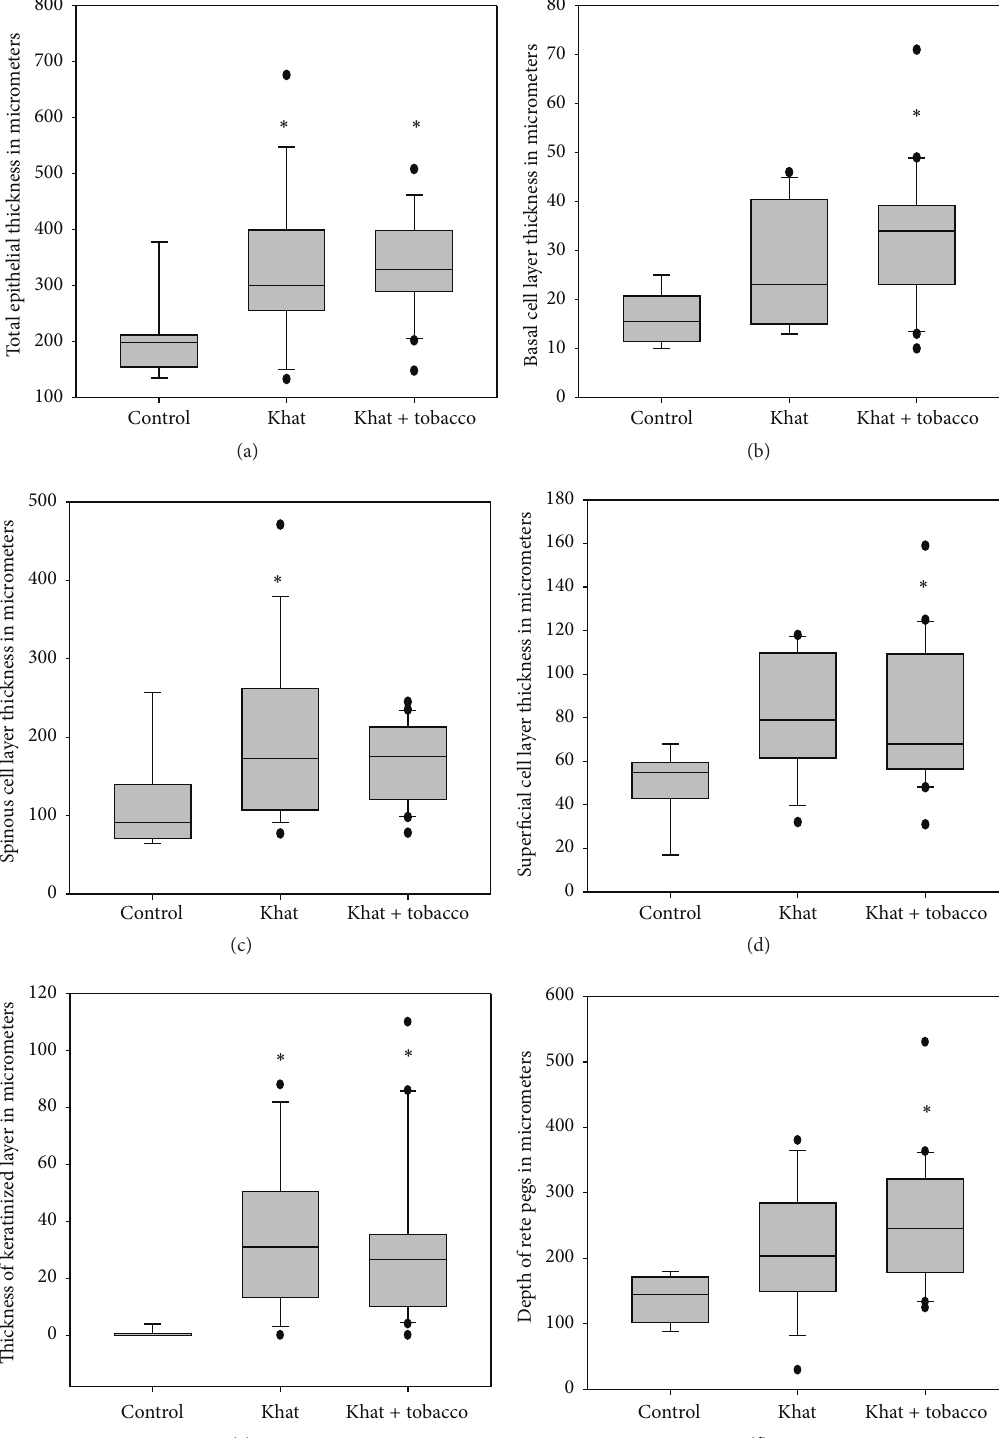
Figure 4: Analysis of the thickness of the buccal epithelium in controls and in study groups. Asterisk ( ∗ ) shows statistically significant differences ( 𝑝 < 0.05 ) between study groups when compared to the control after multiple